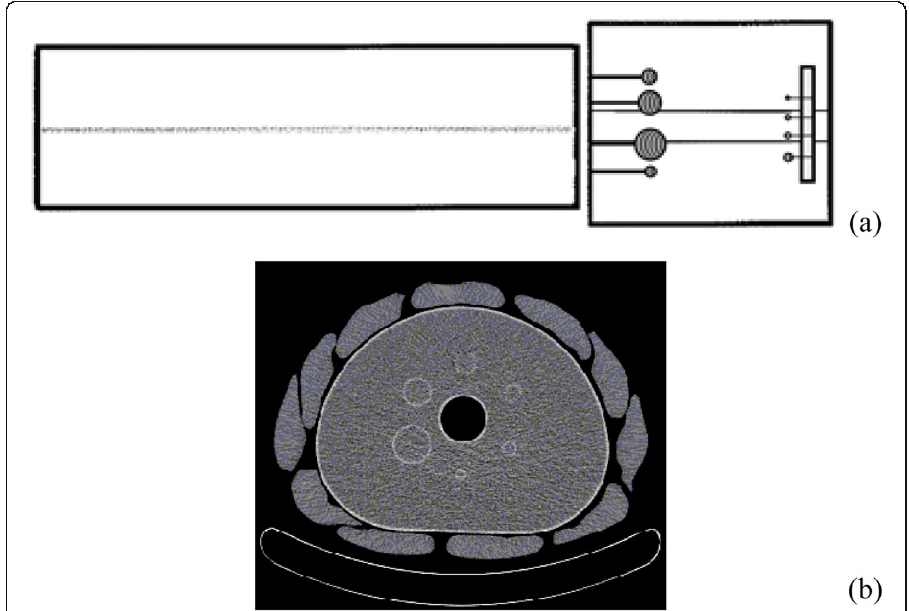
Fig. 1 Phantom setup in antero-posterior view ( a ) and CT scan of the b-NEMA-IQ phantom at standard spheres level ( b